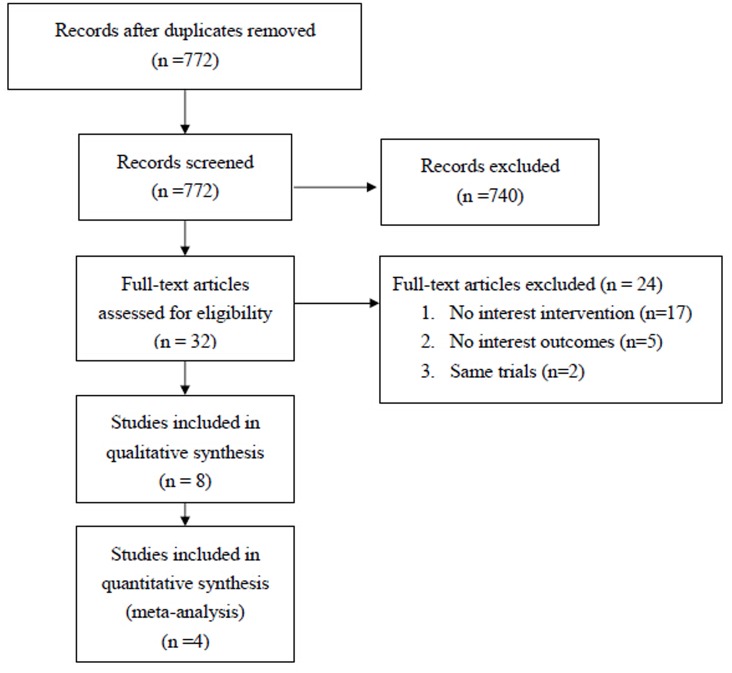
A flow diagram for study selection.